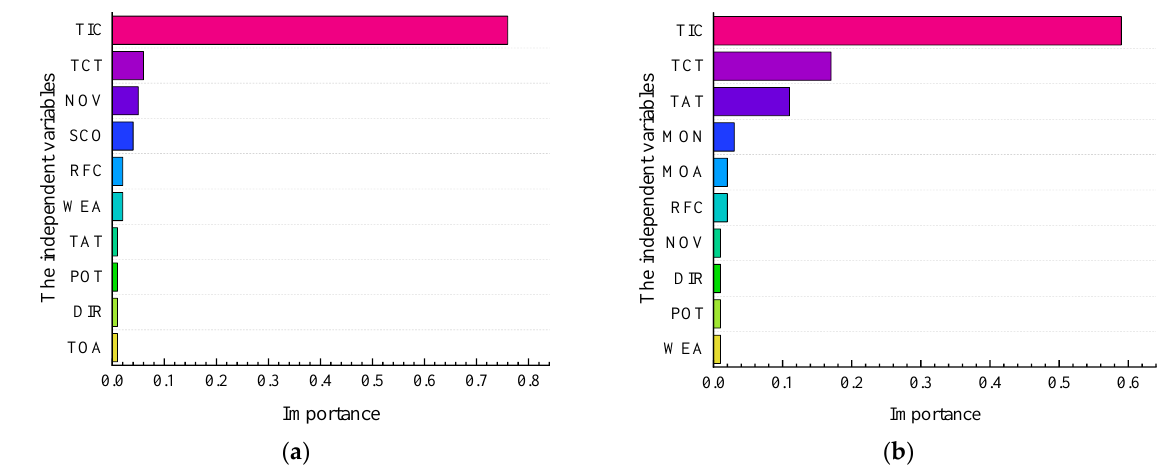
Figure 9. ( a ) The result of the LSSVM model in the SSI area; ( b ) The result of the LSSVM model in the NSI area.